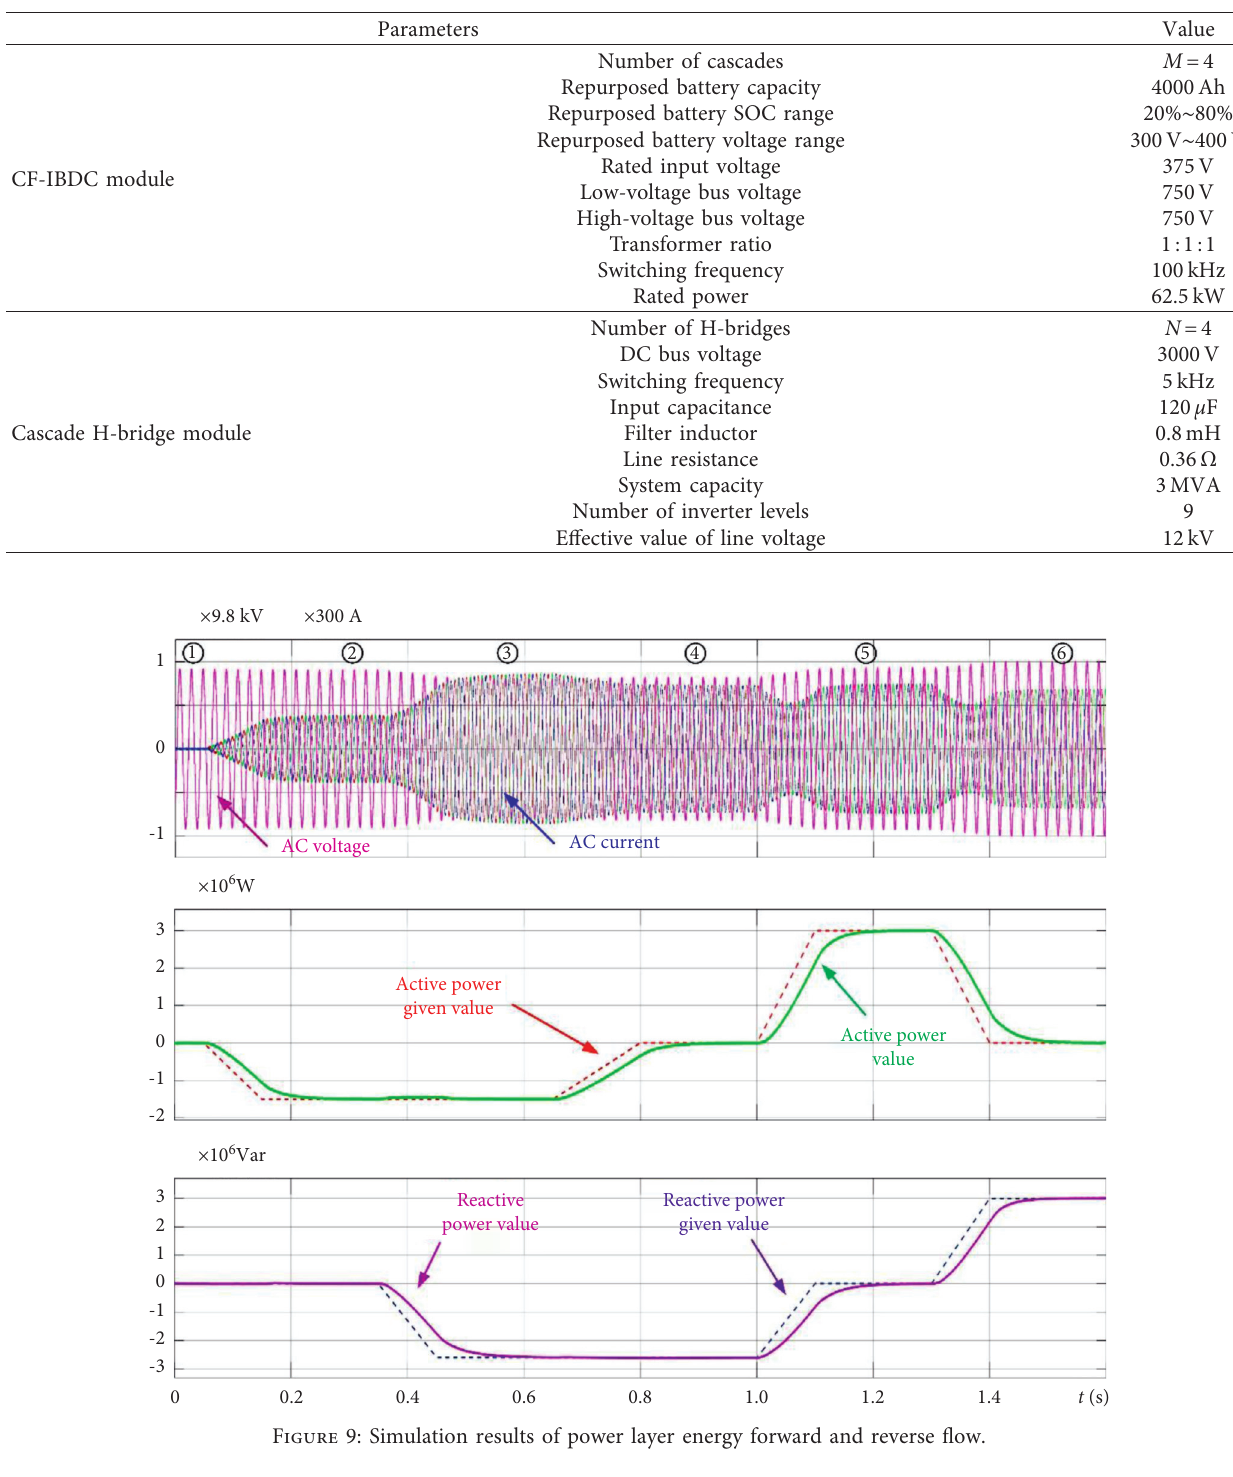
Table 1: Simulation model parameters.